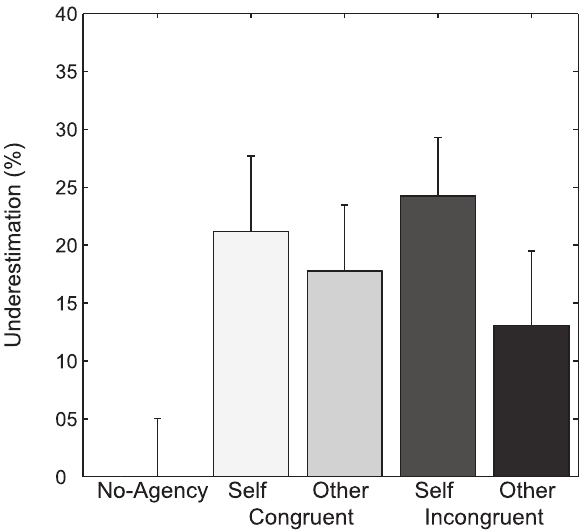
Figure 4. Intentional binding. Values show mean ( + SEM) underes- timation of time intervals in percentage. Congruent/incongruent refers to positioning of the artificial hand relative to the participants hand, self/other refer to the mode of agency.